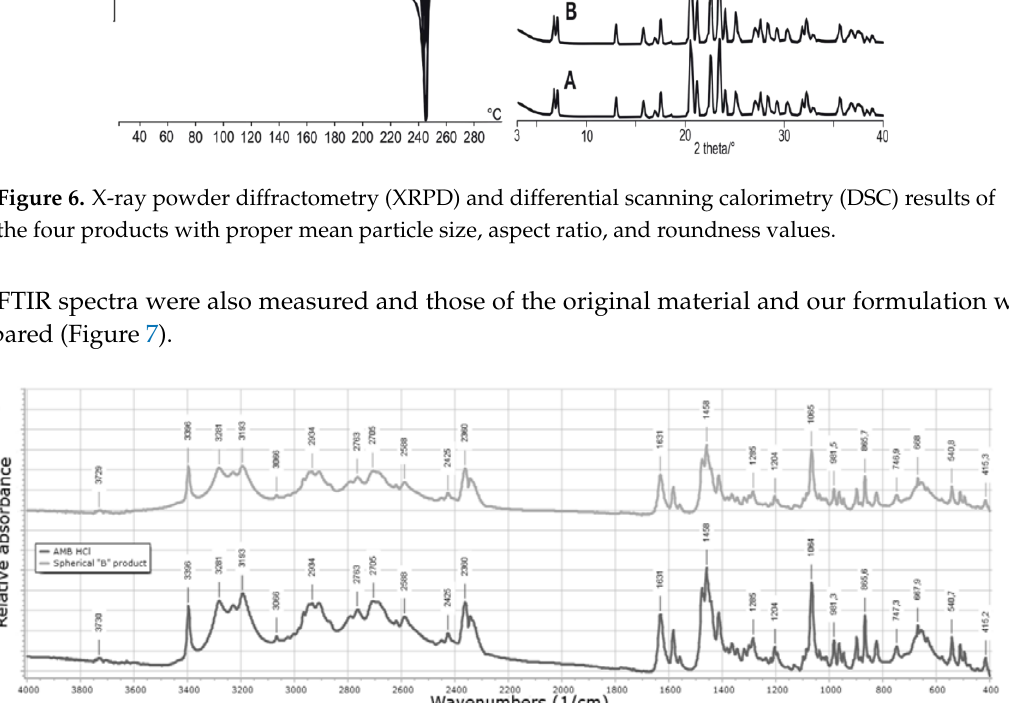
Table 6. Comparison of the initial material and the products made by the spherical agglomeration method (L = low - risk parameter; M = medium - risk parameter; H = high -risk parameter). Initial Material